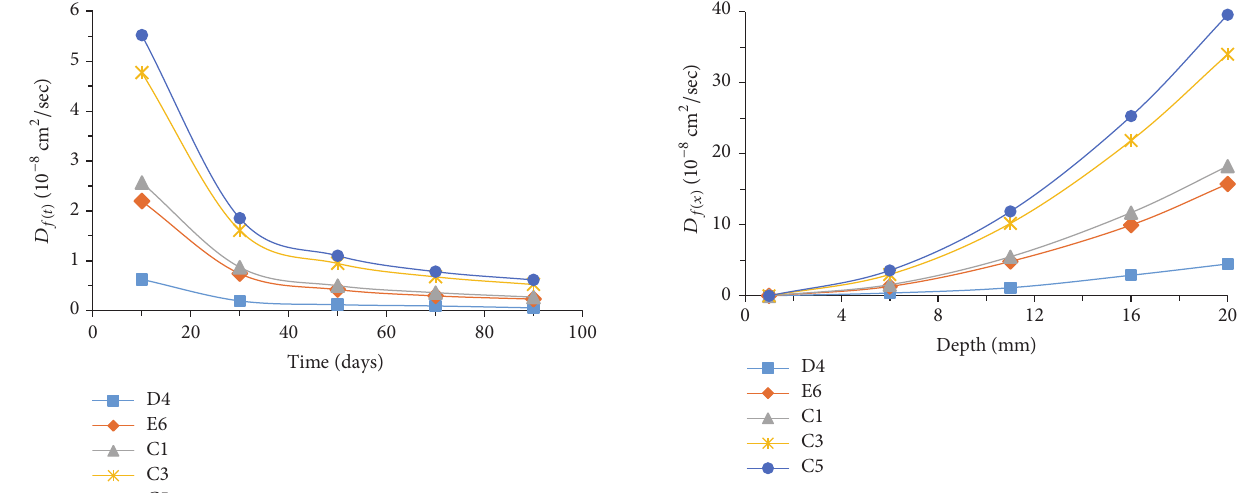
Figure 5: Effect of penetration depth on free chloride diffusion coefficient [26].